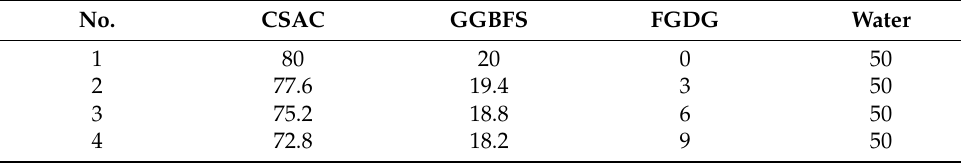
Table 2. Mix proportions (wt